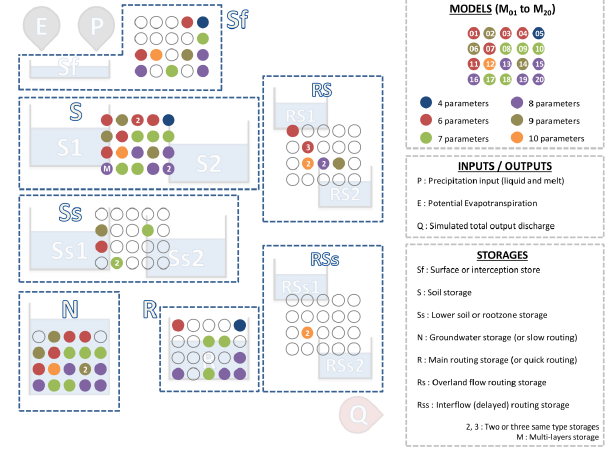
Figure 2: Illustration of the structural diversity of the twenty lumped conceptual models 2 Figure 2. Illustration of the structural diversity of the twenty lumped conceptual